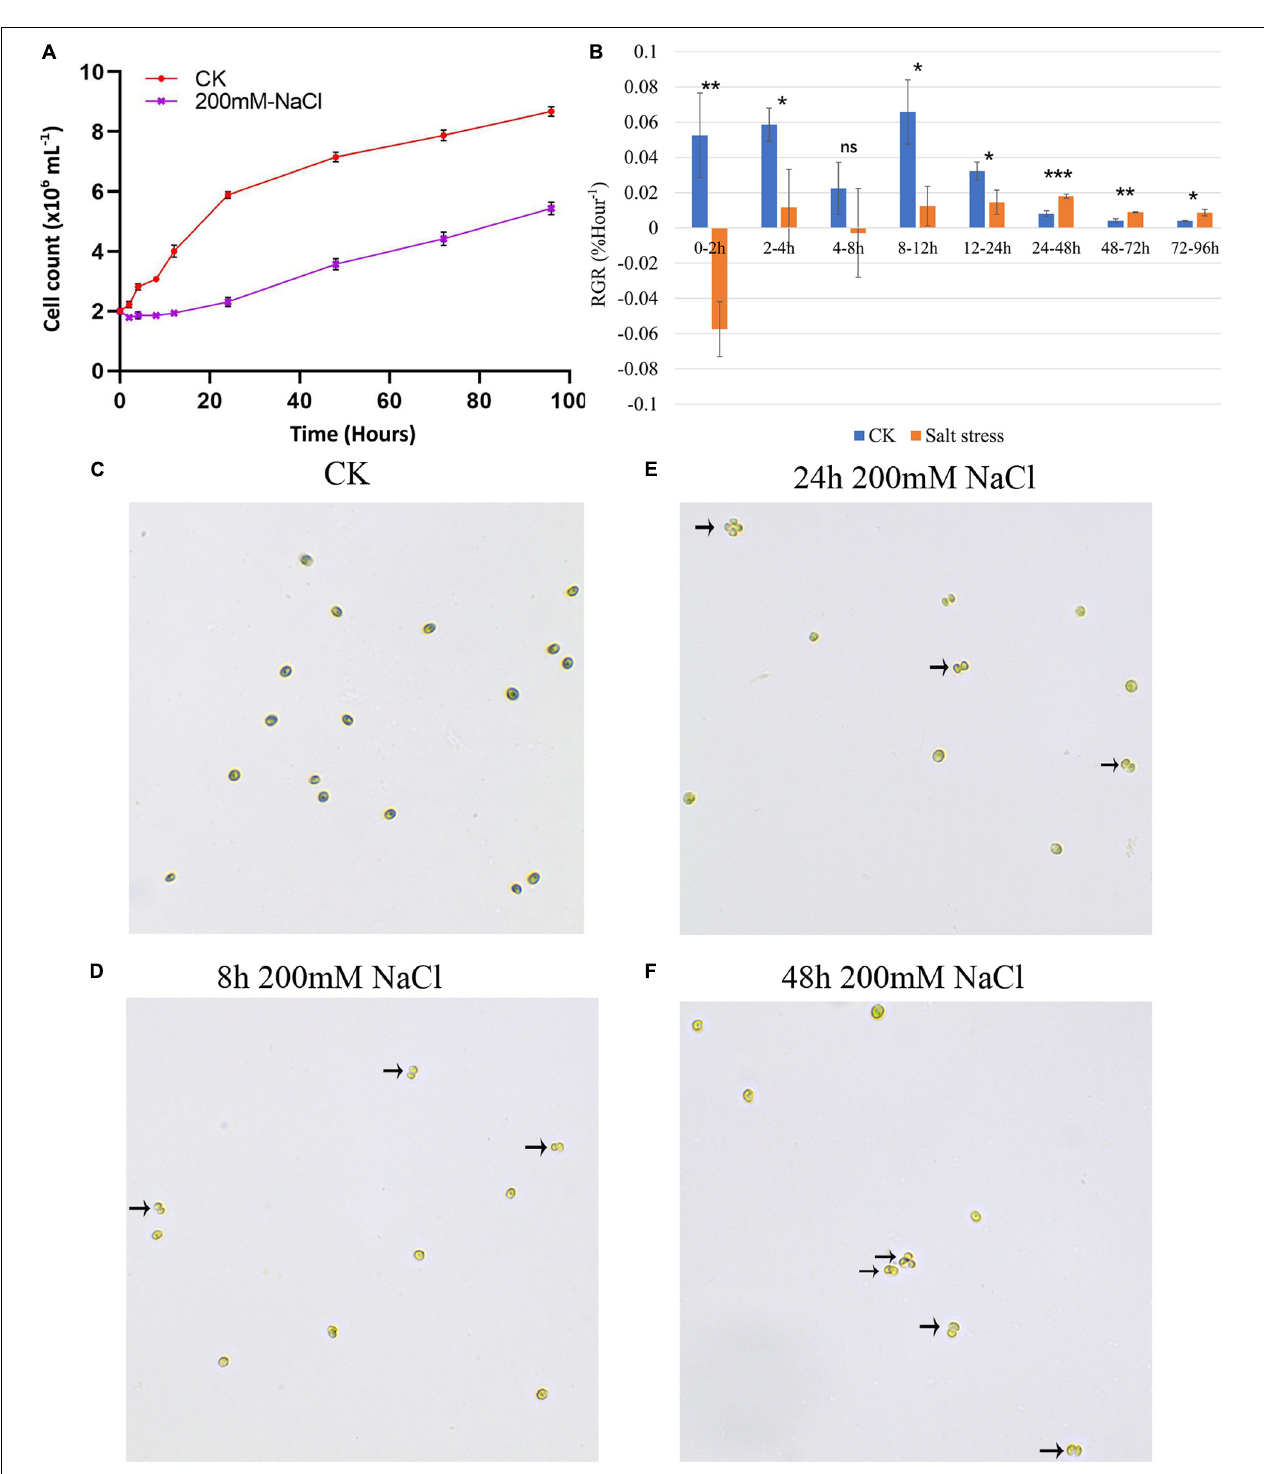
FIGURE 1 | (A) Growth curves of GY-D55 strain during 0 (CK) and 200 mM sodium chloride (NaCl) stress. Growth curves are based on cell count. The scale bar corresponds to 10 µ m. For all experiments n = 3. Error bars show SEM. The t -test results of growth rates in salt-treated samples and control samples at eight time-points were significant ( P -value < 0.05). The morphology of Chlamydomonas reinhardtii GY-D55 cells: (B) changes in relative growth rates (RGR) of the NaCl treated and control groups. Means and SE are shown, n = 3. The statistical differences between salt stress and CK samples RGR were analyzed by one-way ANOVA in R. *** P < 0.001, ** P < 0.01, * P < 0.05, ns means not significant. (C) Without addition of NaCl (CK), (D) 8 h under 200 mM NaCl treatment, (E) 24 h under NaCl treatment, (F) 48 h under NaCl treatment. The palmelloids were marked by a black arrow.